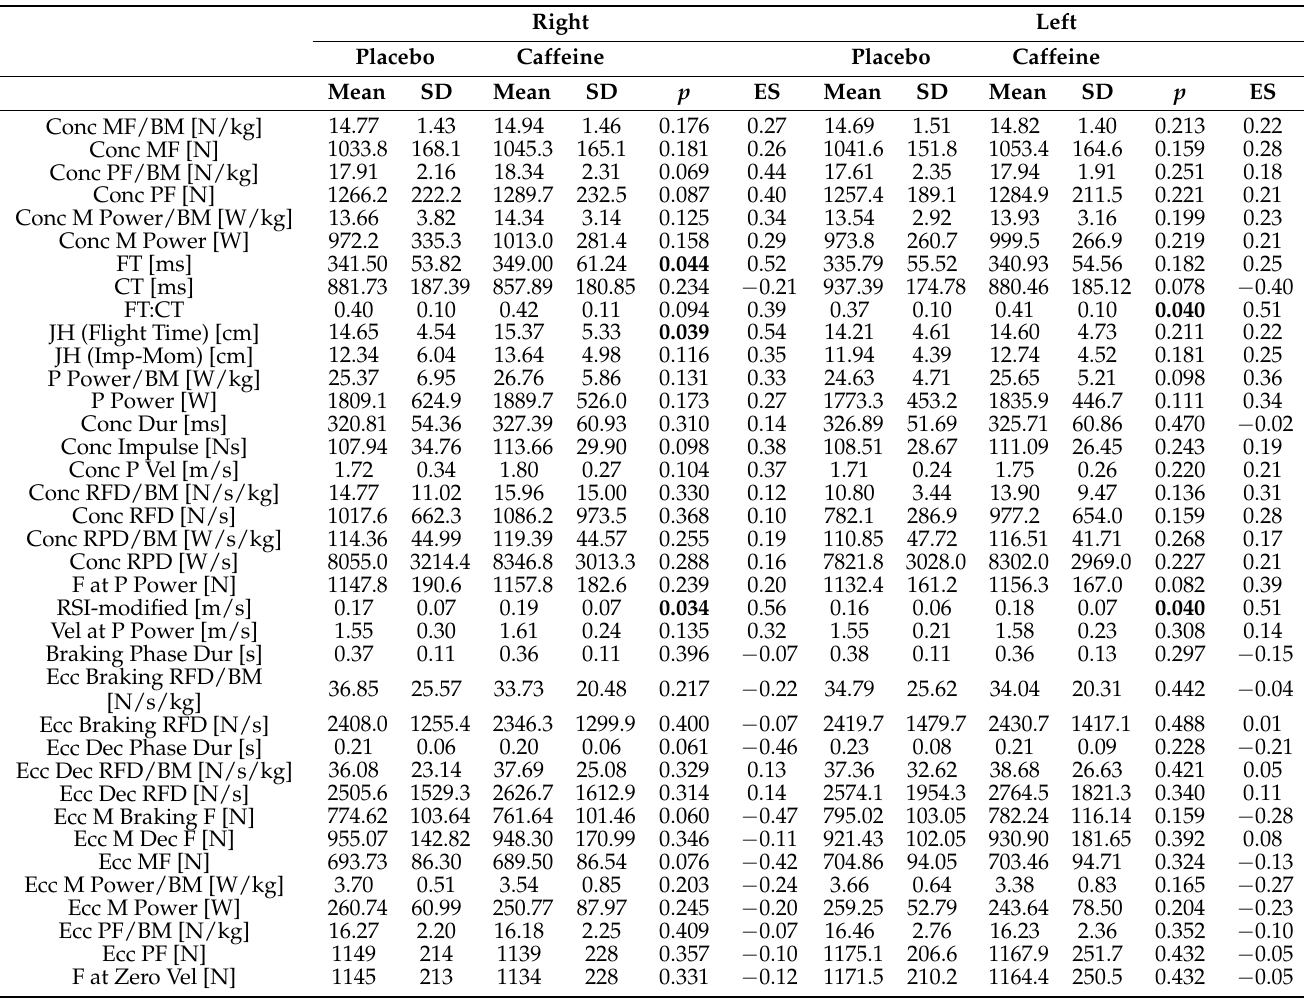
Table 3. Kinetic and kinematic differences between Caffeine and Placebo conditions in the unilateral CMJ. Right Left Placebo Caffeine Placebo Caffeine Mean SD Mean SD p ES Mean Conc MF/BM